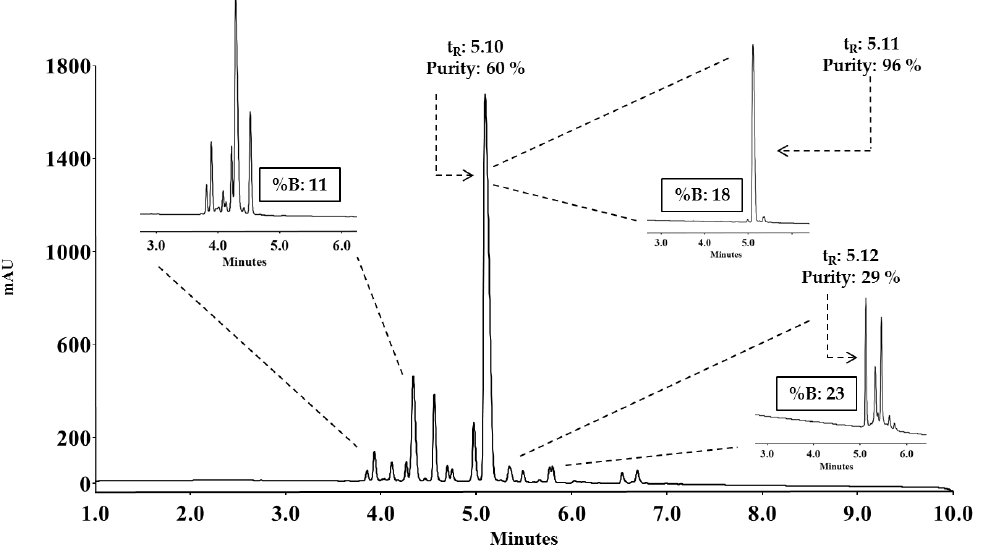
Figure 2. RP-HPLC analysis of crude 2 0–25 LfcinB/ 32–35 BFII. The chromatographic profile shows a main peak at 5.10 min, corresponding to the peptide with a purity of 60%. The chromatographic profile of fractions N ◦ 3, 6, and 11 collected during reversed-phase solid phase extraction (RP-SPE) purification is also shown. Specifically, those fractions contained 11, 18, and 23% solvent B, respectively. Table 1. Program designed for the purification of 20–25 LfcinB/ 32–35 BFII via RP-SPE. The framed fractions correspond to where the purest fraction probably elutes. The final volume of each fraction was 12 mL. Fraction N